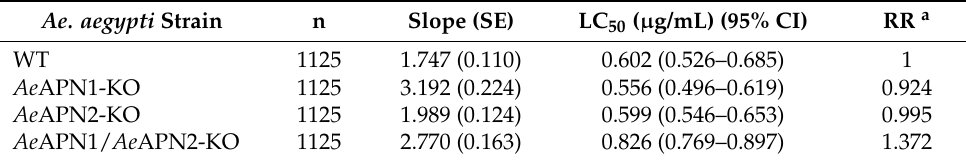
Table 4. Susceptibility of Ae. aegypti strains to Cry11Aa toxin.